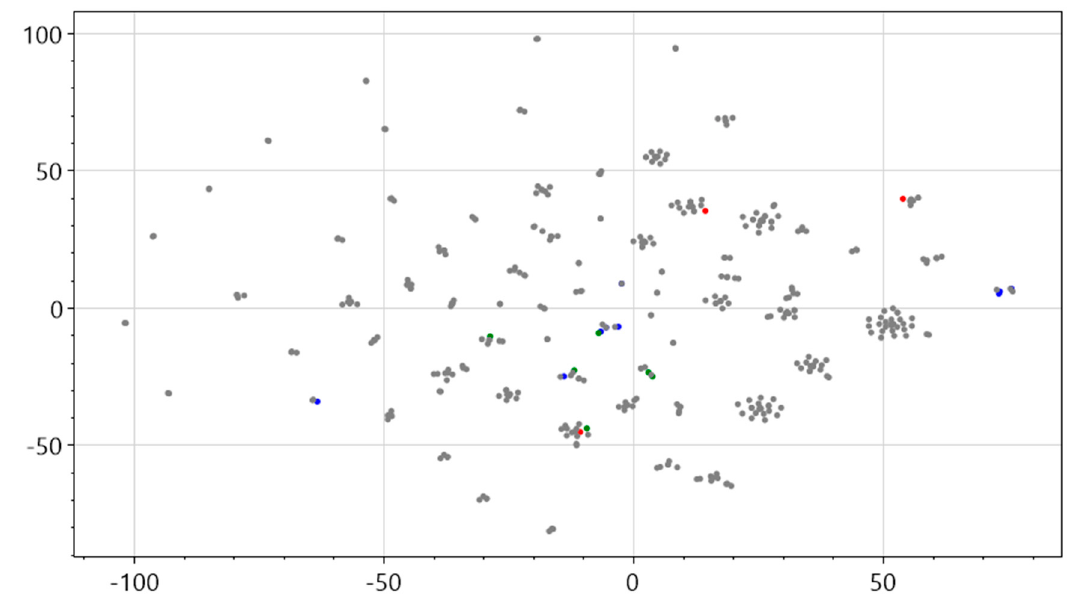
Figure 2. Visualized word vector result .